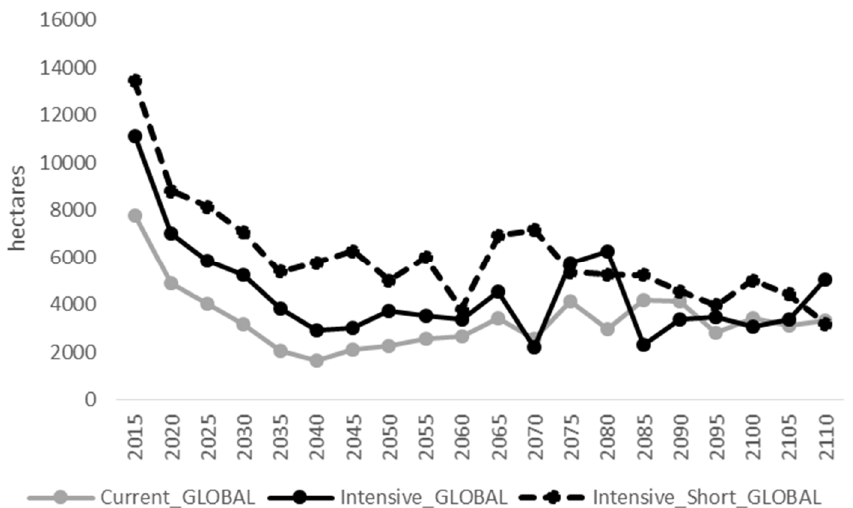
Figure 9. Projected potential areas available for final felling (in hectares) with current management approaches of different intensities in the GLOBAL BIOENERGY scenario.